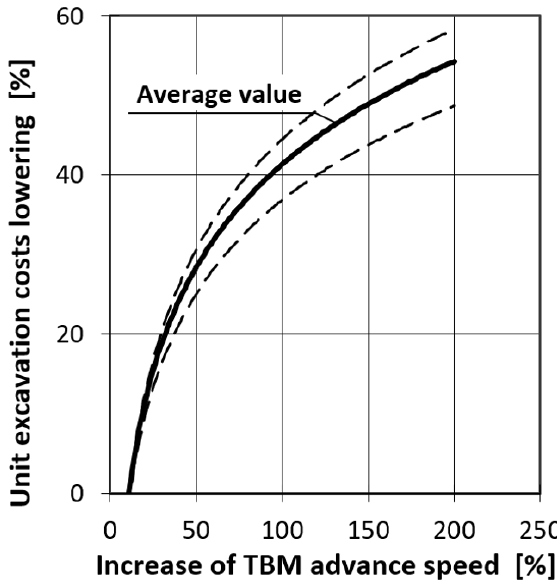
Figure 5. Influence of increasing the speed of mining head advance on the unit costs of roadway excavation [7].